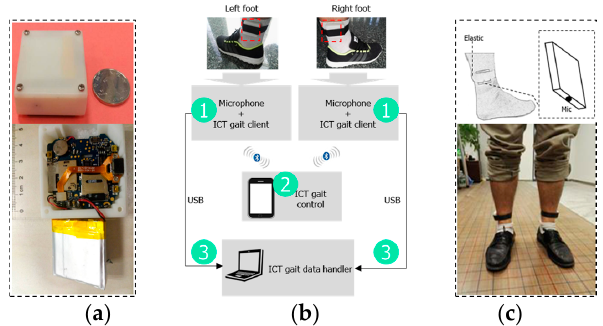
Figure 1. ( a ) Prototype device; ( b ) Software (SW) + hardware (HW) block diagram of the system (green numbers indicate the running sequence of system); ( c ) Wearing method.